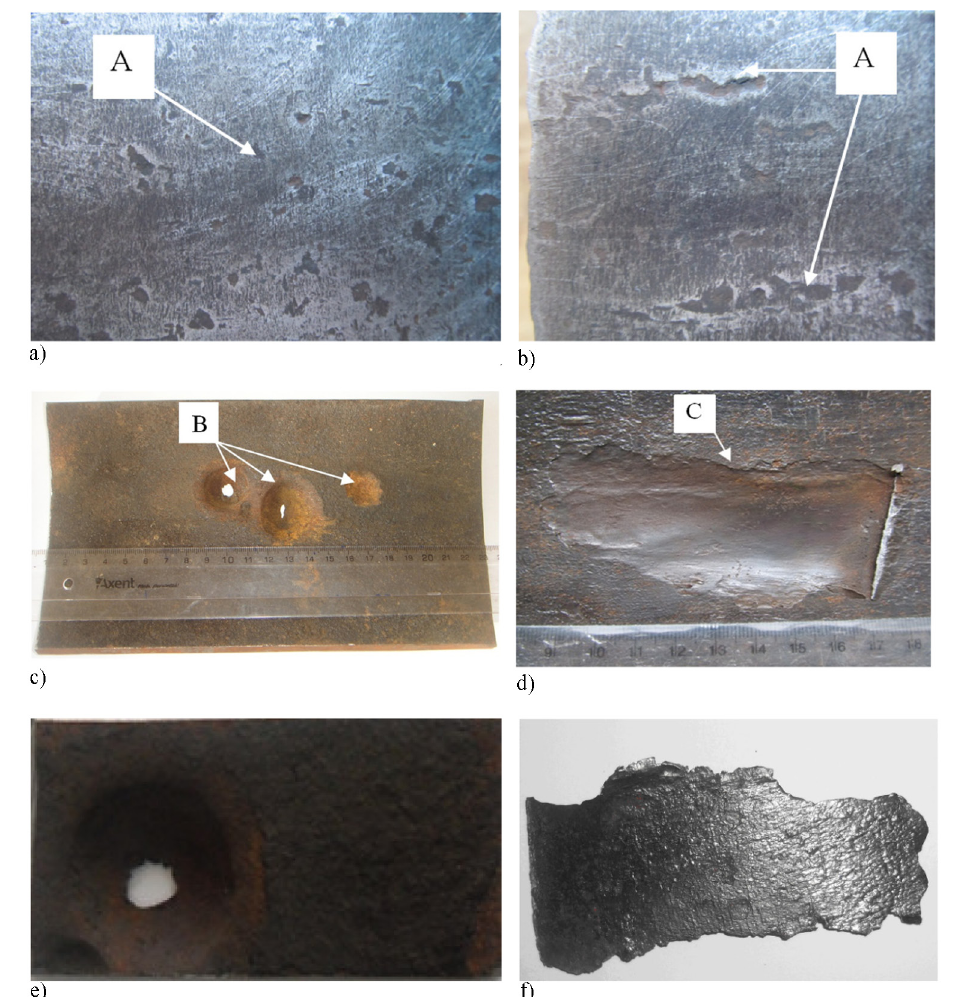
Fig. 2. Investigated in-service defects of oil and gas pipelines: а, b – pitting; d, f – film peeling; c, e – megalospheric corrosion pits; A, B, C – defects are indicated by